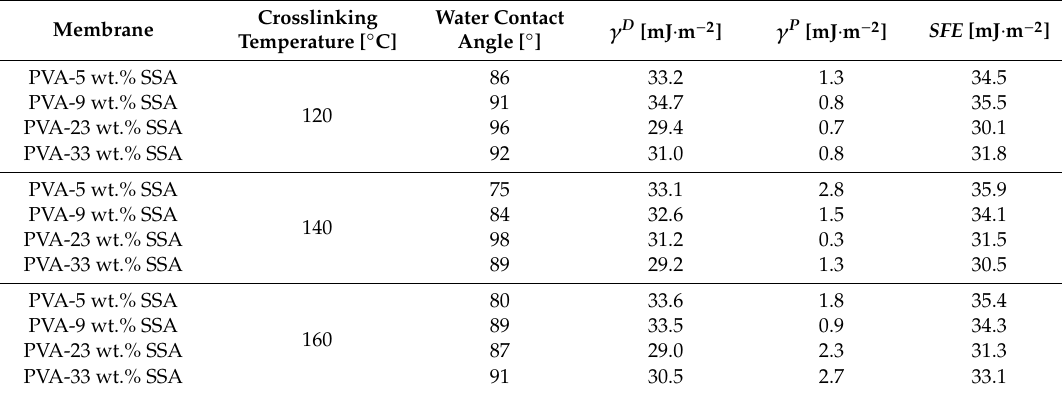
Table 3. Water contact angle and surface free energy dispersive γ D and polar γ P components for the crosslinked PVA-SSA